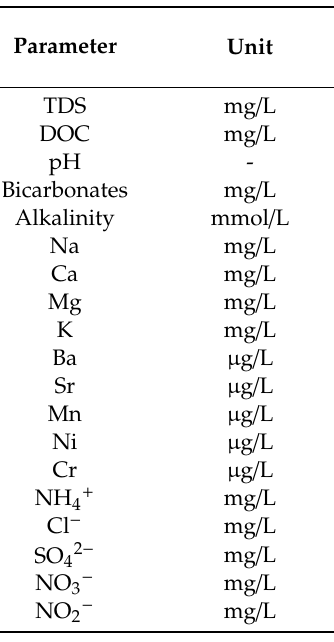
Table 2. The physicochemical characteristics of the three studied karstic